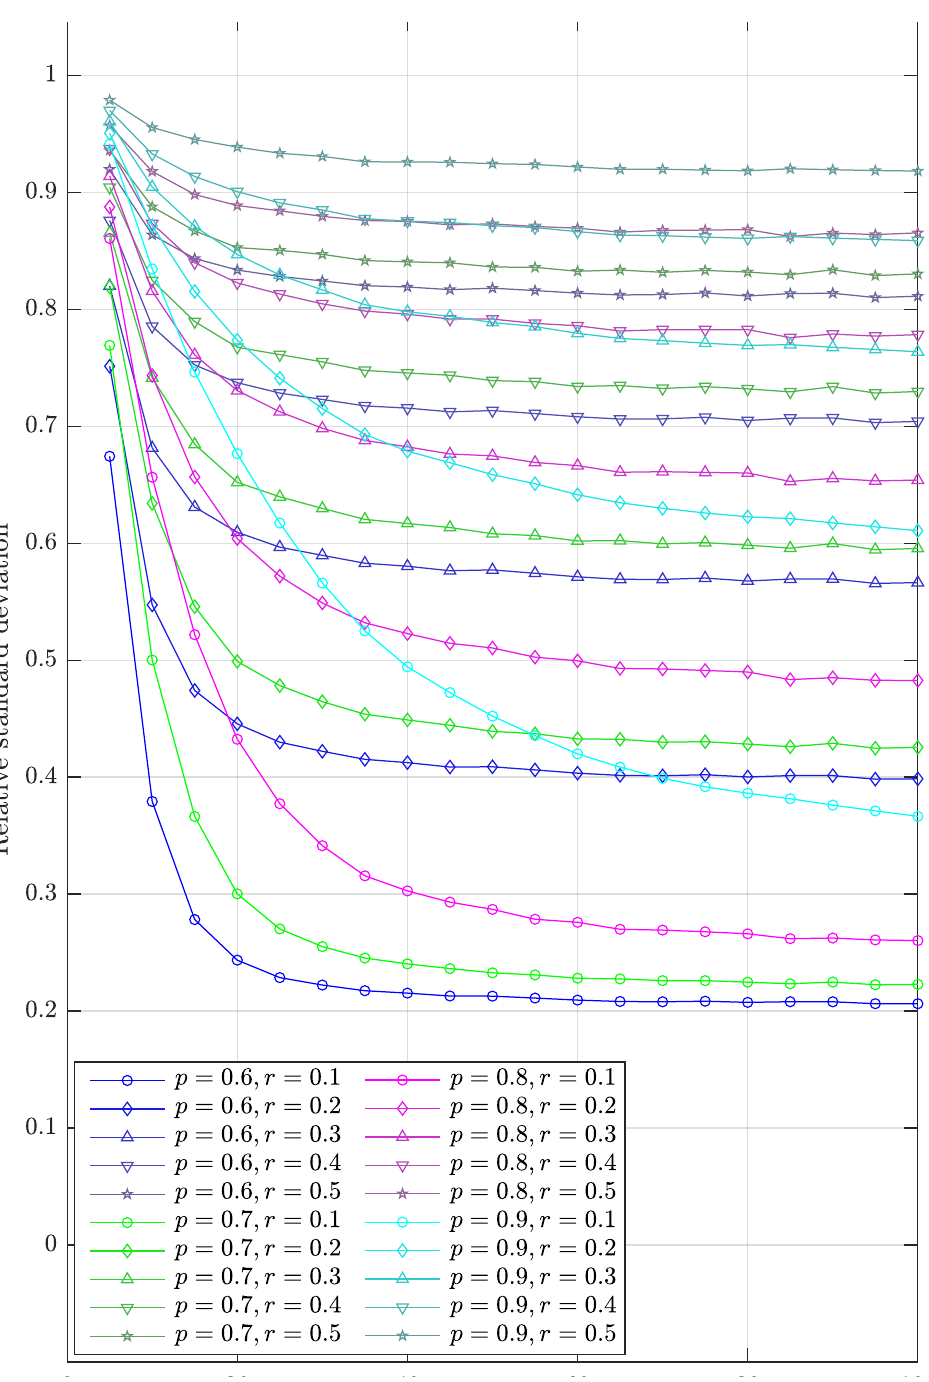
Figure 3. Relative standard deviation (heteroskedastic rms over homoskedastic rms) of the fitted slope k for all 20 combinations of p and r in the range 5 ≤ n ≤